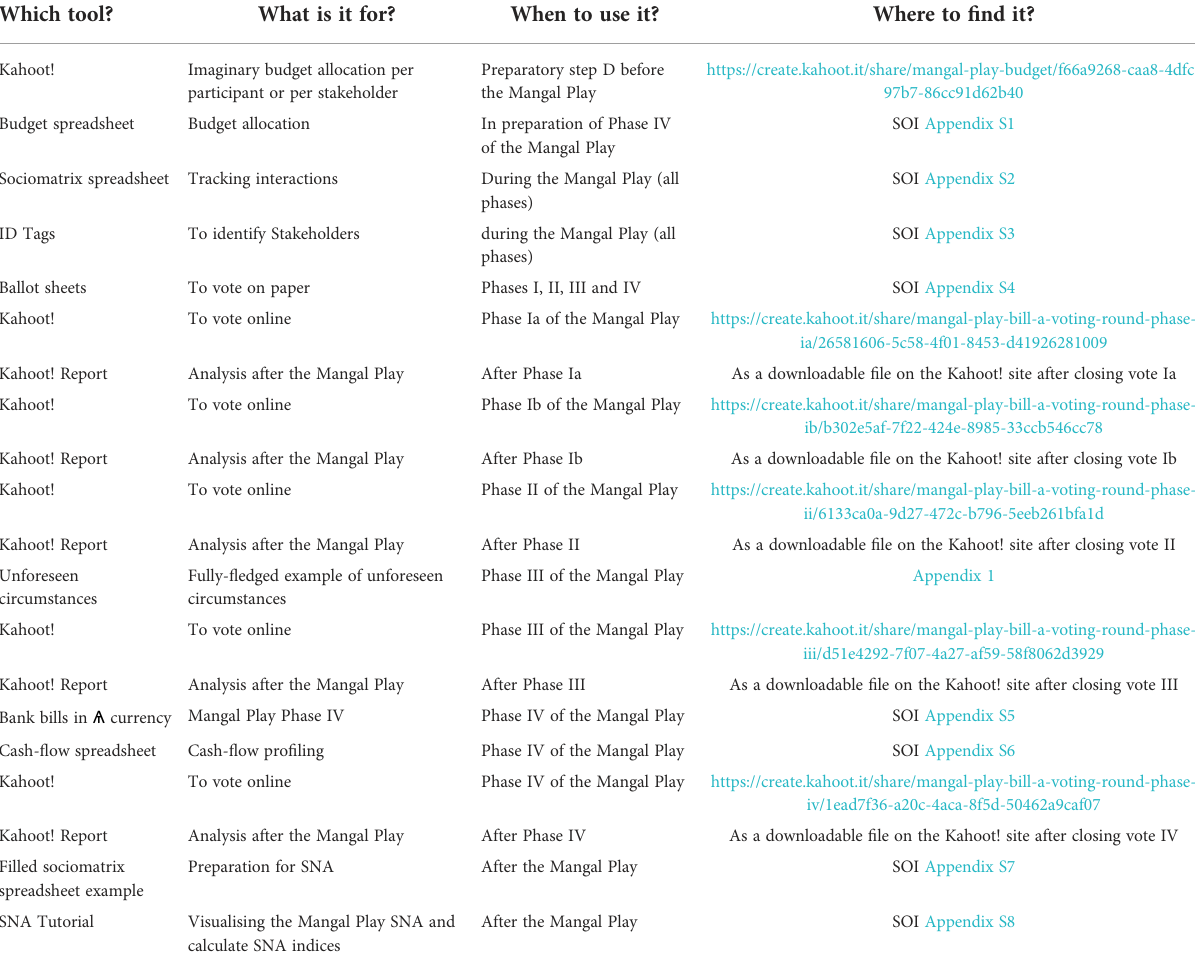
TABLE 3 Overview of the online tools and resources, what/when they are for (see also Section 4) and where to fi nd them, listed in order in which they are needed chronologically before, during and after the Mangal Play. Which